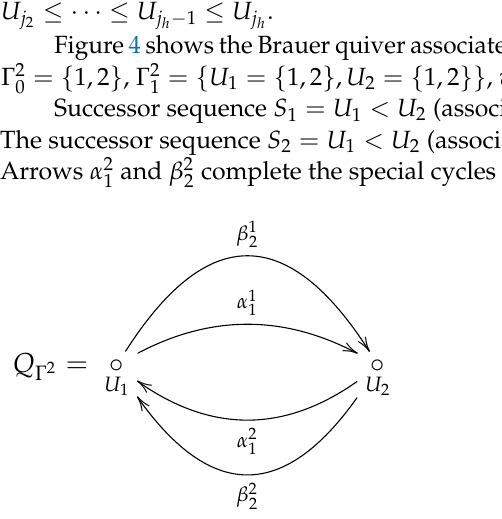
Figure 4. Example of the Brauer quiver defined by the Brauer configuration Γ 2 . Relations α 1 α 1 α 2 α 1 α 1 α 2 β 2 β 1 β 1 β 2 , α 2 , β 1 , β 2 , L i , (where L i denotes the special cycle associated with the vertex j in polygon U i , i = 1,2) generate the admissible ideal I Γ 2 for which the Brauer configuration algebra Λ Γ 2 = F Q Γ 2 / I Γ 2 .